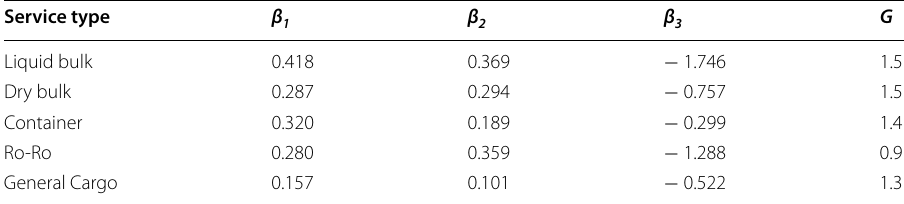
Table 8 Values of gravity model parameters Service type